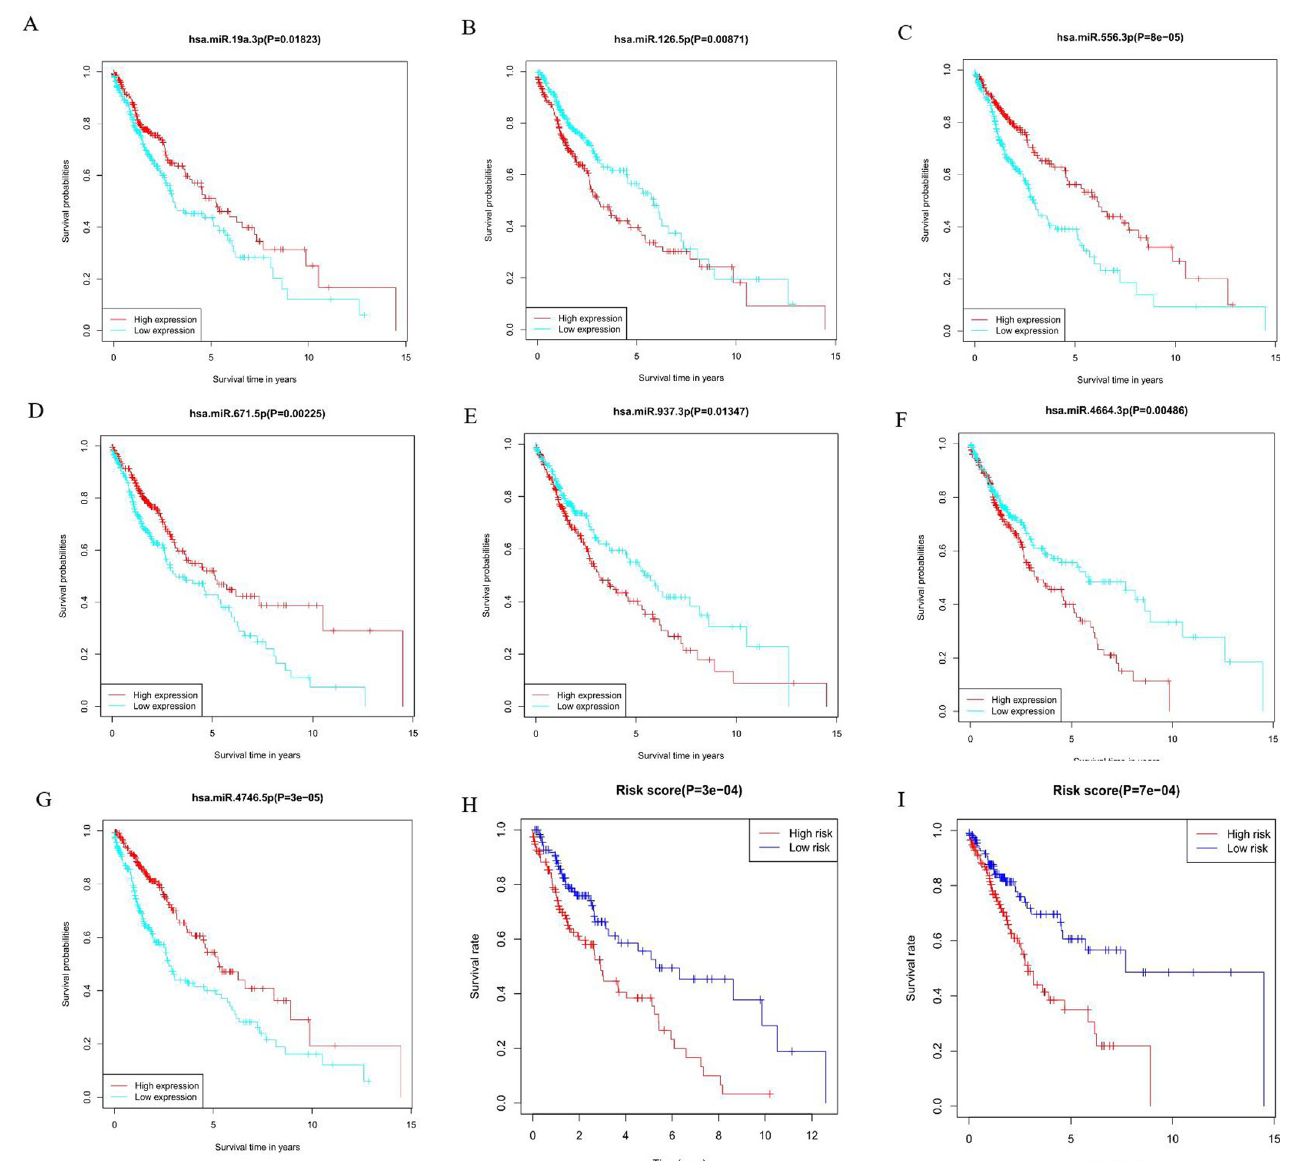
Fig 4. Overall survival analysis of 7 miRNA, the training set and testing set. A-G: miRNAs; H: Training set; I: Testing set.